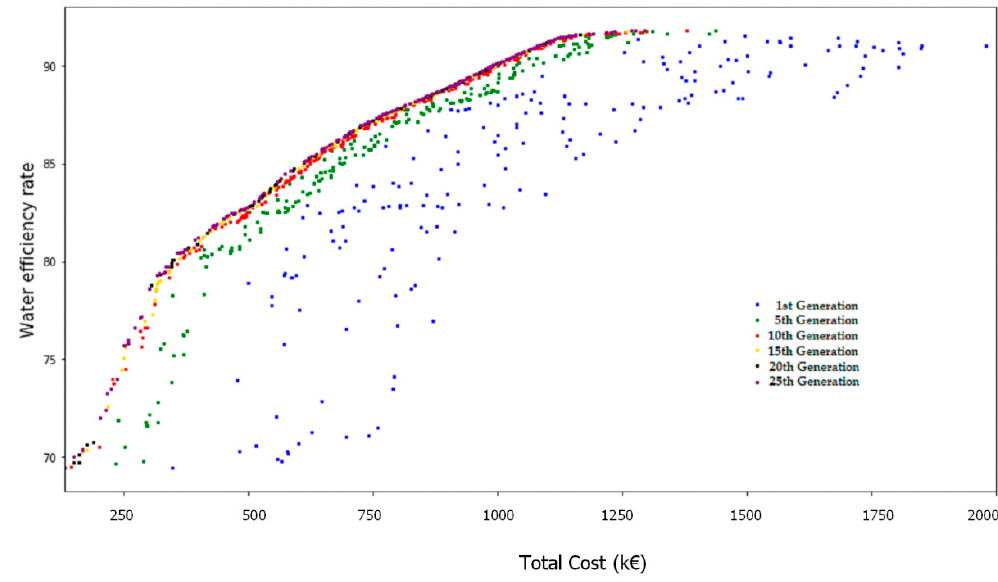
Figure 7. Evolution of Pareto front after 25 generations. Table 7. Definition of decision variable constraints.